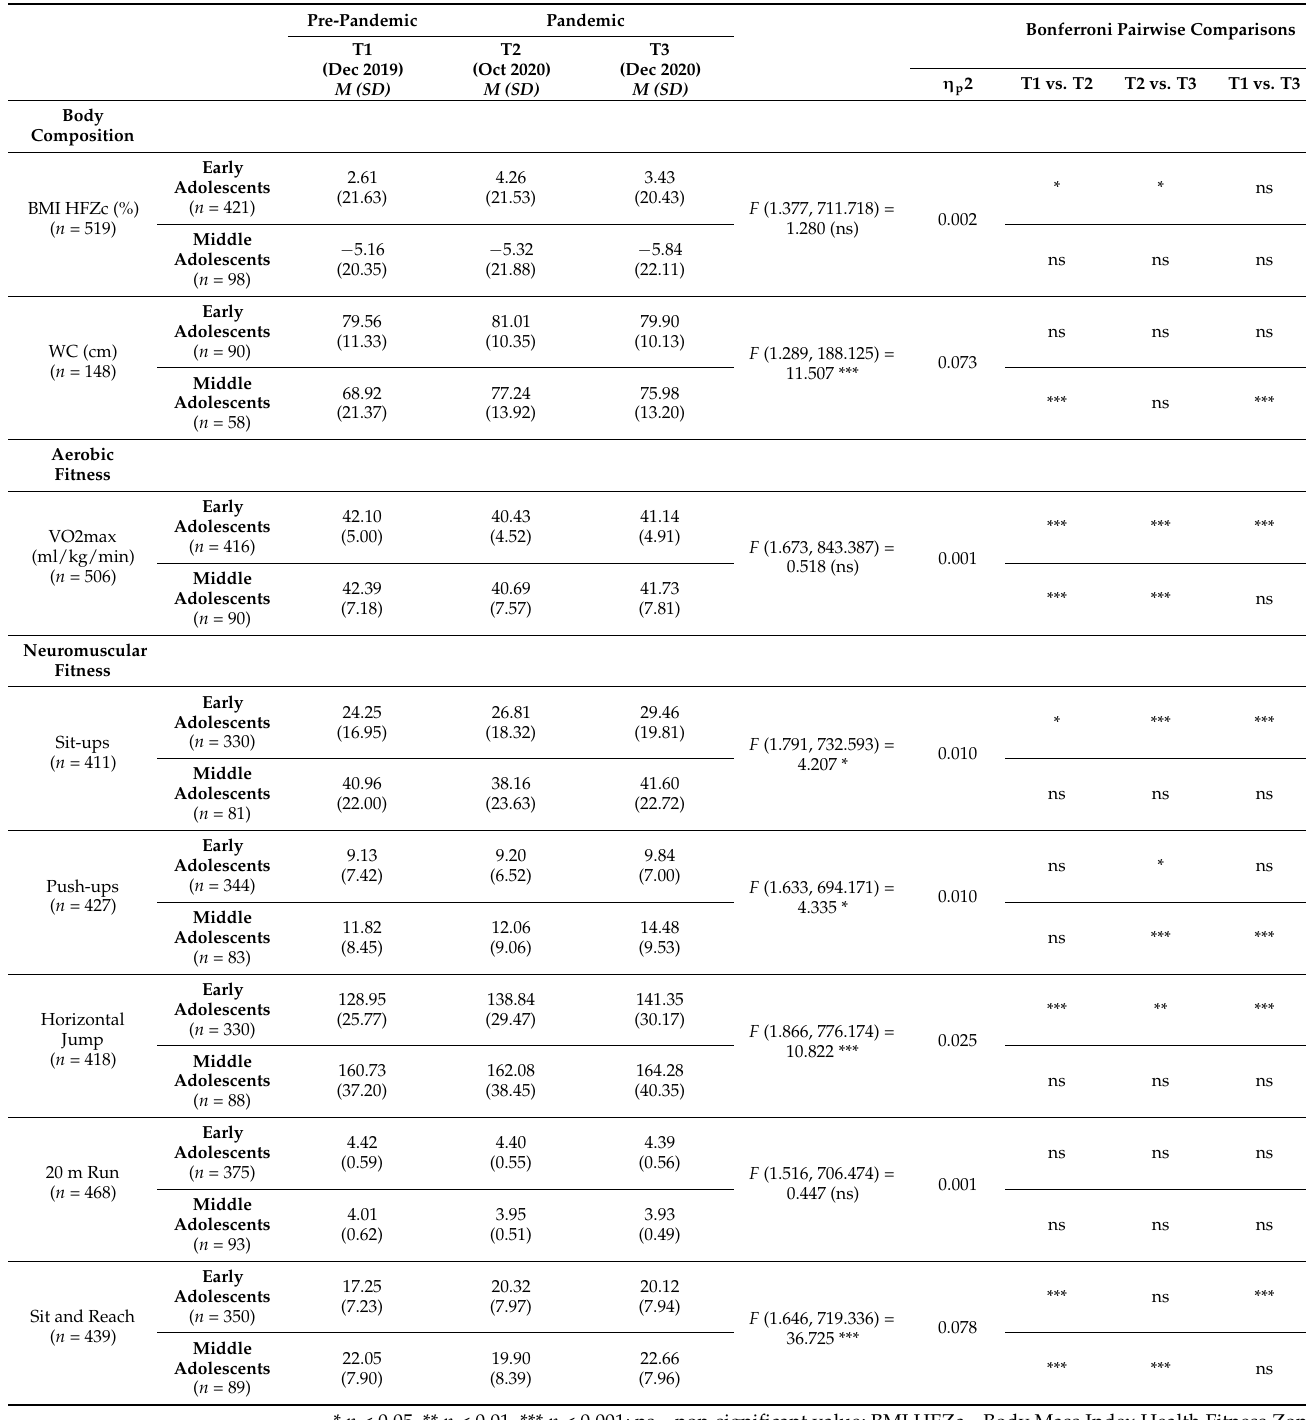
Table 3. Mixed model ANOVA and Bonferroni pairwise comparisons of early and middle adolescents’